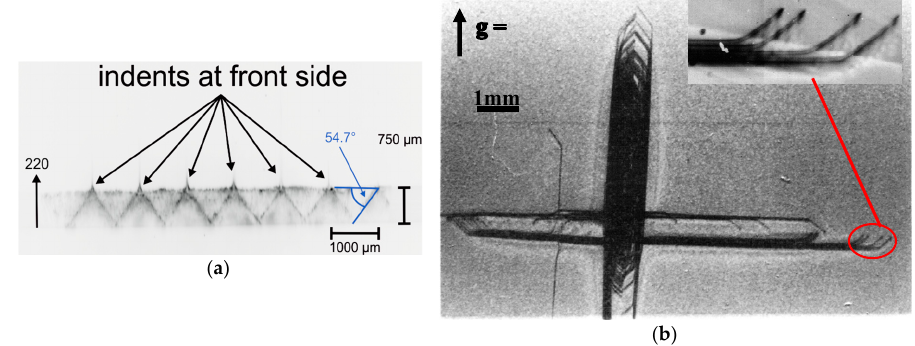
Figure 8. ( a ) X-ray section topograph of slip dislocations generated on {111} glide planes from surface indentations upon annealing. ( b ) X-ray diffraction image of the early stages of cross slip leading to thickening of the dislocation loops into a slip band and nucleation of the orthogonal slip systems.